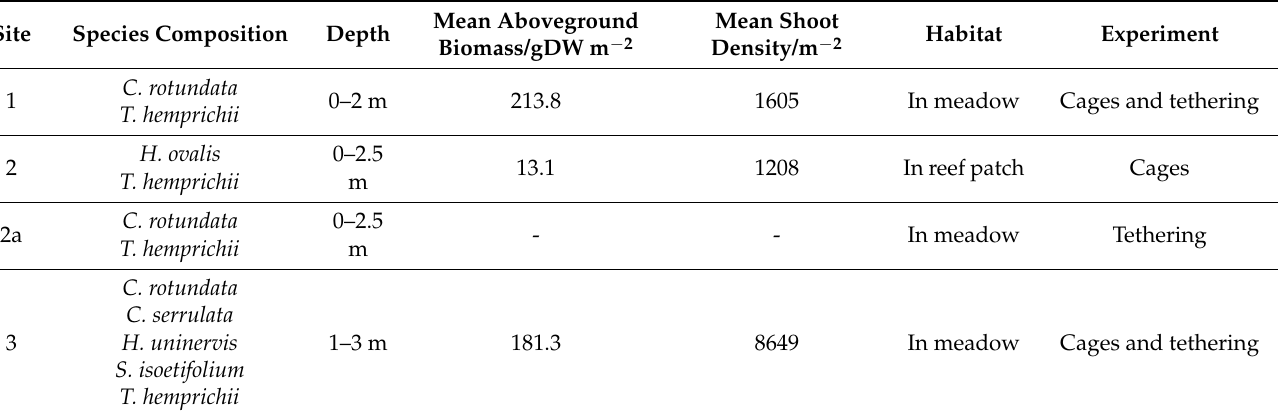
Figure 1. Map of study sites. Table 1. Characteristics of the different sites used in this study.